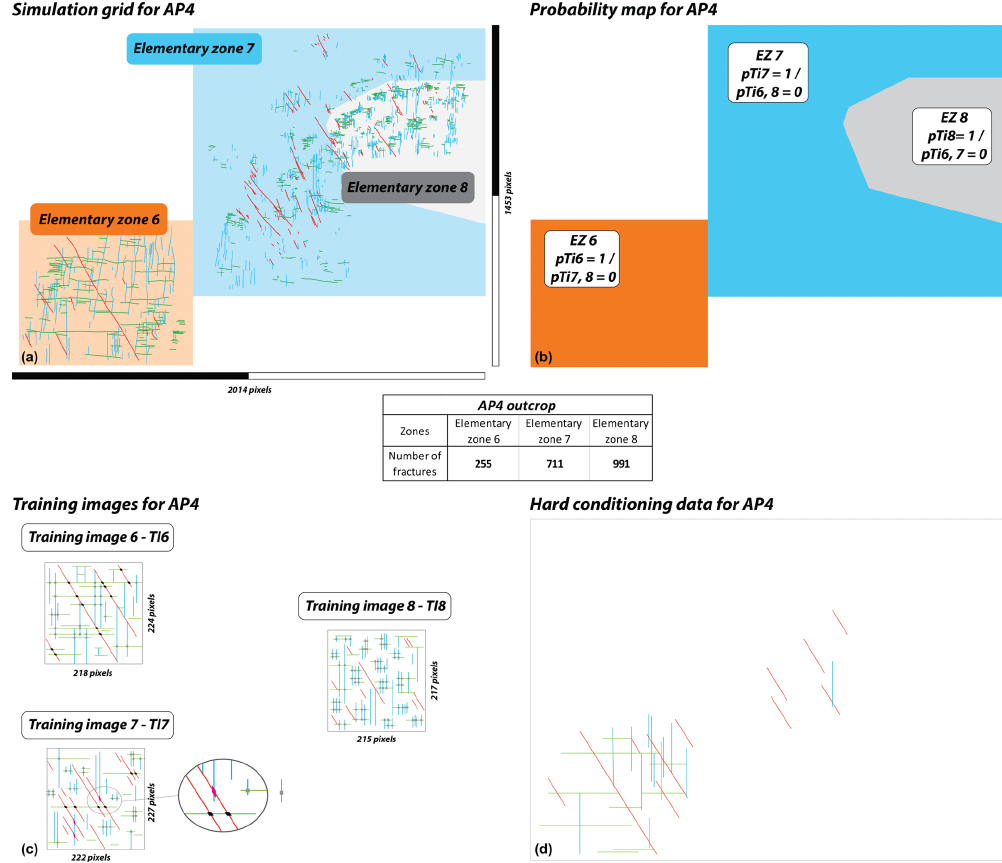
Figure 11. (a) Partitioning of AP4 in three EZs. (b) Probability map and associated statistics for each EZ. (c) Training images associated with the partitioning of AP4. (d) Hard conditioning data for